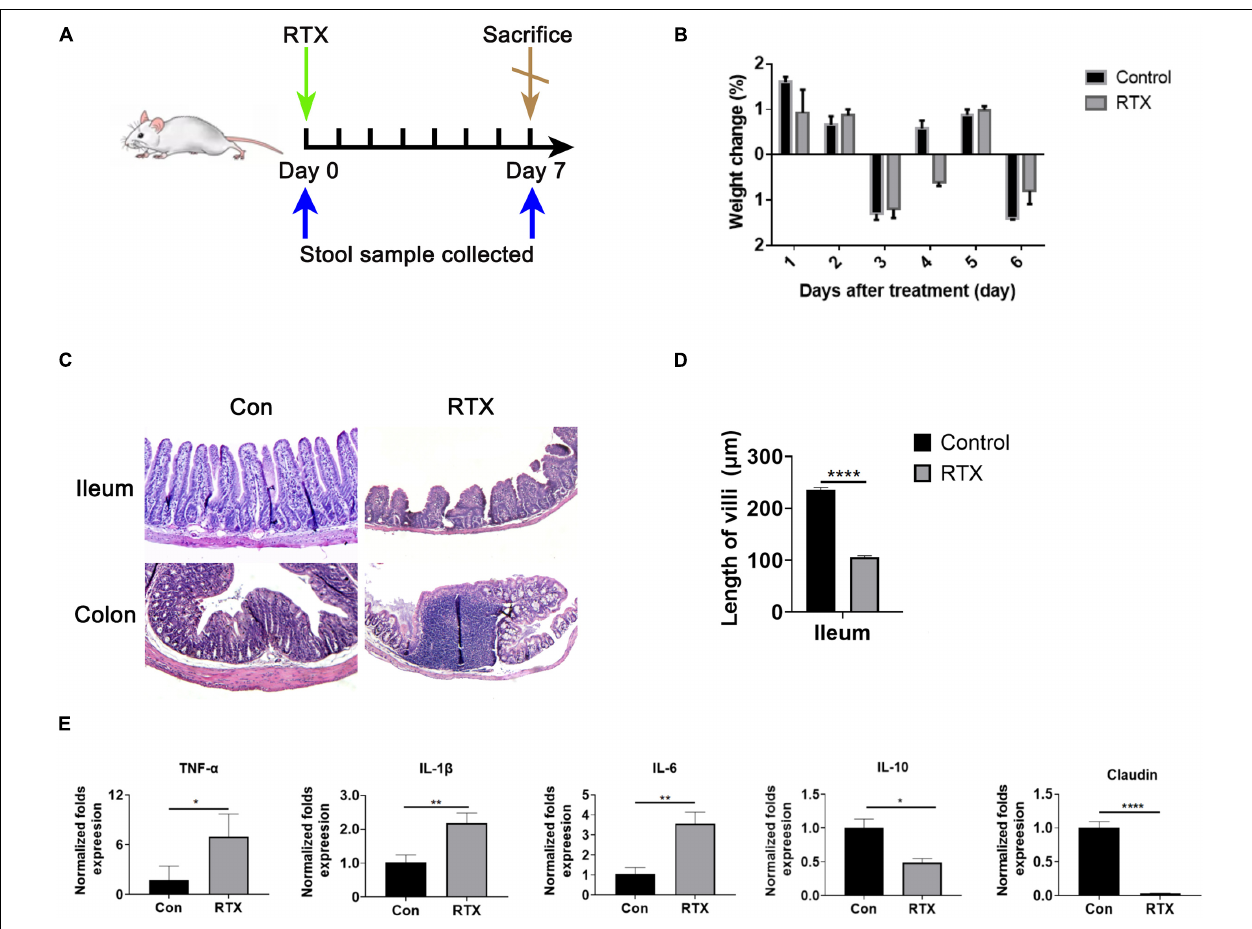
FIGURE 1 | Rituximab (RTX) causes marked intestinal mucositis. (A) Schematic diagram of RTX administration and stool sample collection. BALB/c mice were intraperitoneally injected with RTX or normal saline on day 0 and then sacrificed on day 7. Feces were collected before and after treatment. (B) From day 0 to day 7, the body weights of mice in the control and RTX treatment groups were changed. (C) H&E staining of the ileum and colon (magnification, 40 × ). (D) Villus length of ileum and colon. (E) Expression levels of TNF- α , IL-1 β , IL-6, IL-10, and claudin in the ileum of mice treated with RTX or normal saline. Data are expressed as the mean ± SEM. * p < 0.05, ** p < 0.01, **** P <